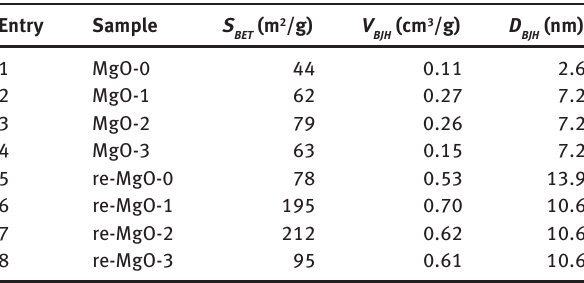
adsorptione/desorption isotherms of materials A. Figure 2: N 2 Table 1: Textural properties of magnesia